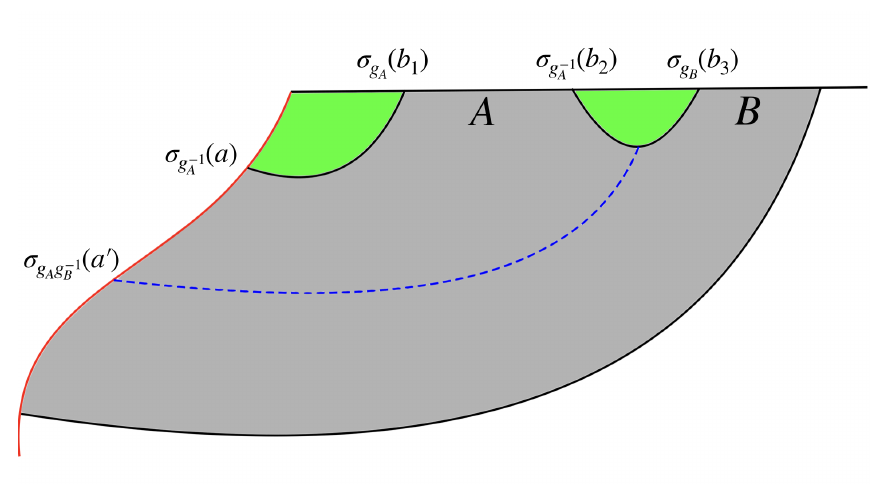
Figure 5: Schematic for the island proposal-II for the entanglement negativity of the disjoint intervals in phase-I. The emergent twist operators corresponding to the reflected entropy are depicted. Figure modified from [ 68